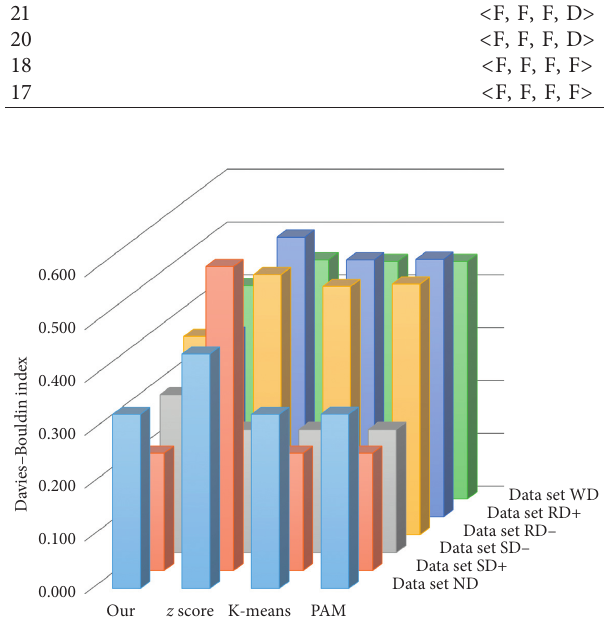
Figure 7: Performance of each method given each data